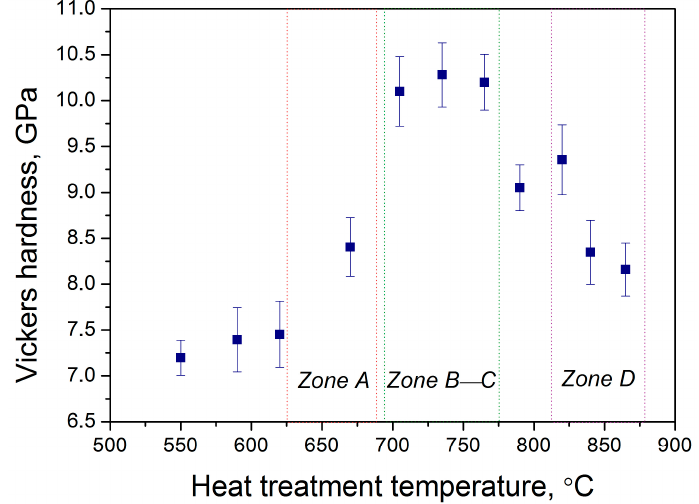
Figure 8. Vickers hardness values along the glass sample after the polythermal crystallization.